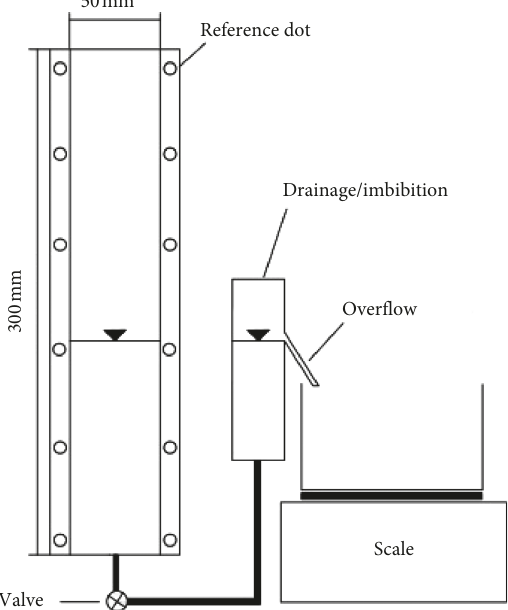
Figure 3: Column apparatus for calibration test.